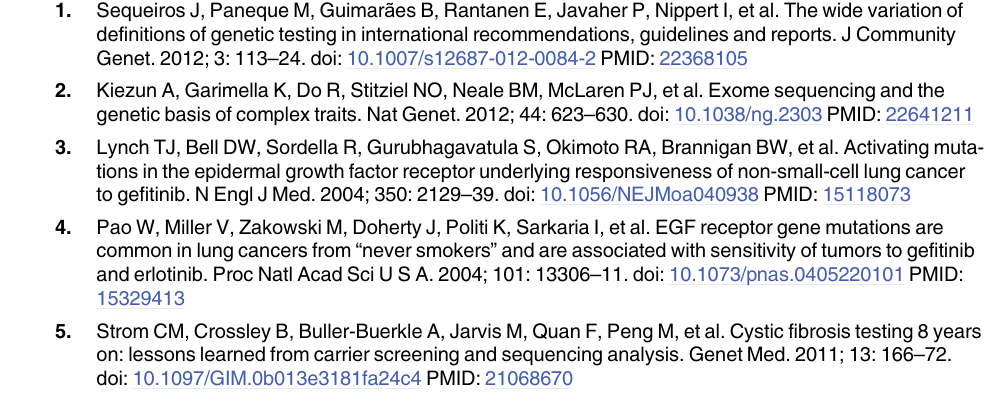
S4 Fig. Comparison of HumanOmni 2.5M microarray (HO2.5) with sequencing. Number of HumanOmni 2.5M sites genotyped by microarray analysis and WGS. (PDF) S5 Fig. Location of SNPs or INDELs relative to the probed base in HumanOmni2.5 array. Histogram showing number of SNPs or INDELS at different positions relative to the probed SNP on the Illumina HumanOmni2.5 array. S1 Table. Genotyping of 96 SNPs related to myocardial infarction by MI Risk Plus kit and WGS. S2 Table. Genotypes of 2040 sites carrying a protective allele on the hg19 reference genome genotyped by WGS. S3 Table. Genotypes of 1025 sites carrying a risk allele on the hg19 reference genome geno- typed by WGS. S4 Table. Genotyping of known variants (dbSNP 141 + Clinvar) with a minor allele on ref- erence (MAF < 50%) by WGS. S5 Table. Genotyping of known variants (dbSNP 141) with a minor allele on reference (MAF < 5%) by WGS. S6 Table. Genotyping of ClinVar pathogenic and drug response variants by